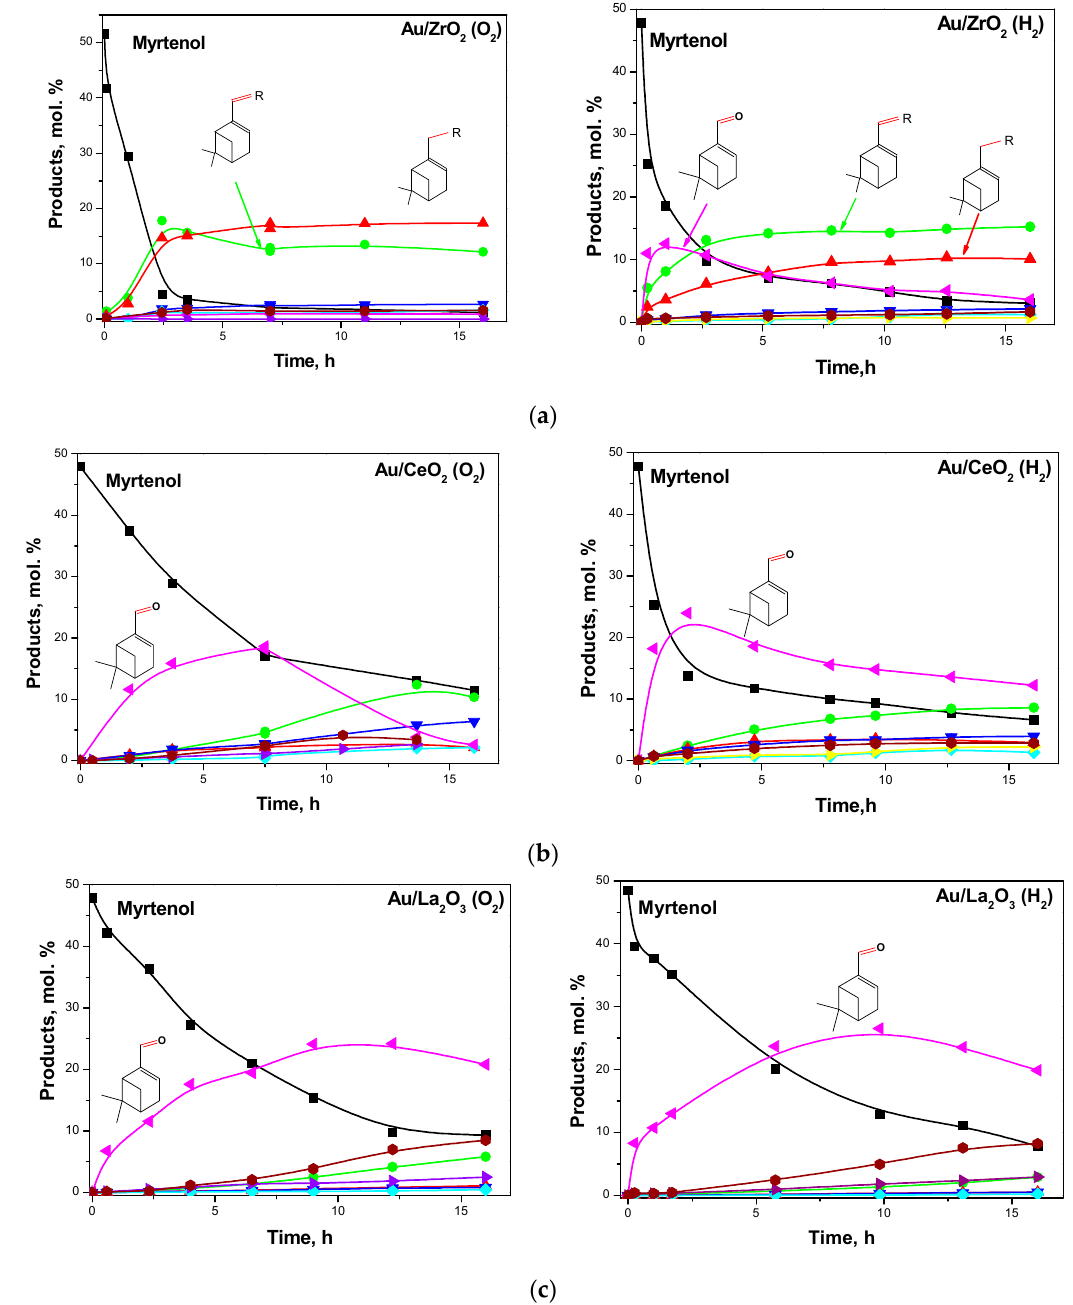
Figure 25. The products distribution as a function of the reaction time during myrtenol amination over Au/ZrO 2 ( a ), Au/CeO 2 ( b ), Au/La 2 O 3 ( c ) pre-treated in O 2 (left) or in H 2 (right). The reaction products: myrtenol ( ■ ), myrtenal ( ◄ ), myrtanol ( ), myrtanal ( ► ), 1 ( ● ), 2( ▲ ), 3 ( ), 4 ( ▼ ). The reaction conditions: T = 180 °C, myrtenol 1 mmol, aniline 1 mmol, toluene 10 mL, catalyst 1.4 mol% Au. Reprinted from [137] with permission from Elsevier.